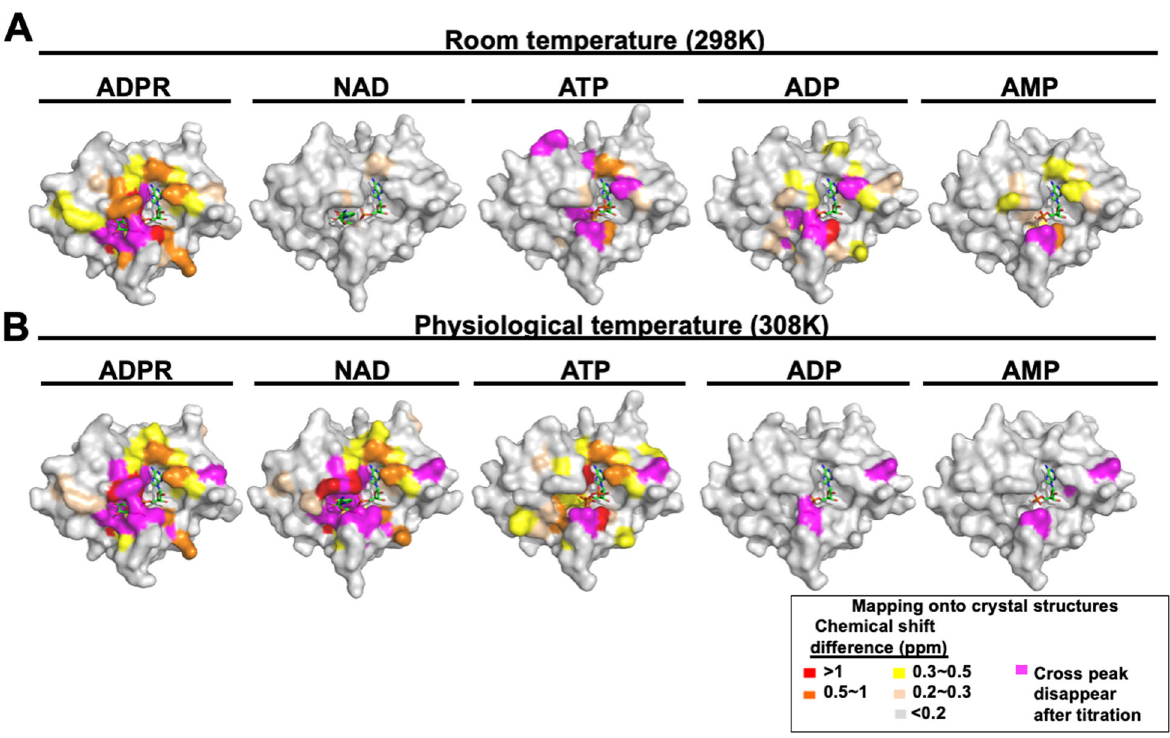
Fig. 4 Surface mapping of the MERS-CoV macro domain with signi fi cant chemical shift changes observed in NMR perturbation at 298 K (A) and 308 K (B). Surface colors of the MERS-CoV macro domain in complex with various NAD metabolites according to chemical shift difference upon ligand titration.